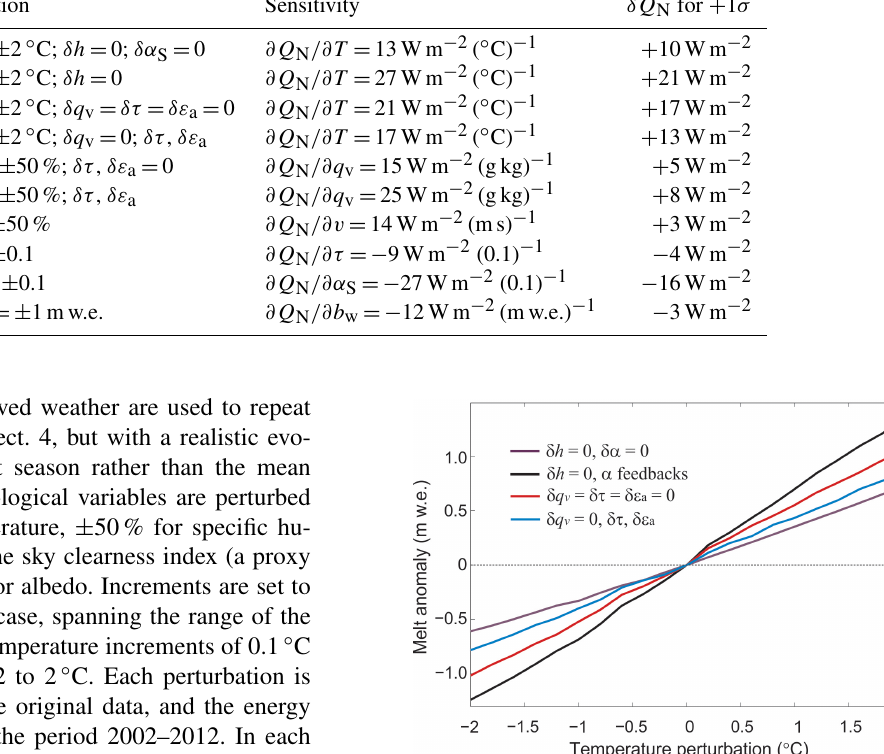
Table 4. Net energy balance sensitivity to meteorological perturbations in the surface energy balance model, based on regressions to the sensitivity curves (cf. Fig. 6). Also shown is the change in net energy associated with a 1 σ increase in each parameter, averaged over JJA. Perturbation